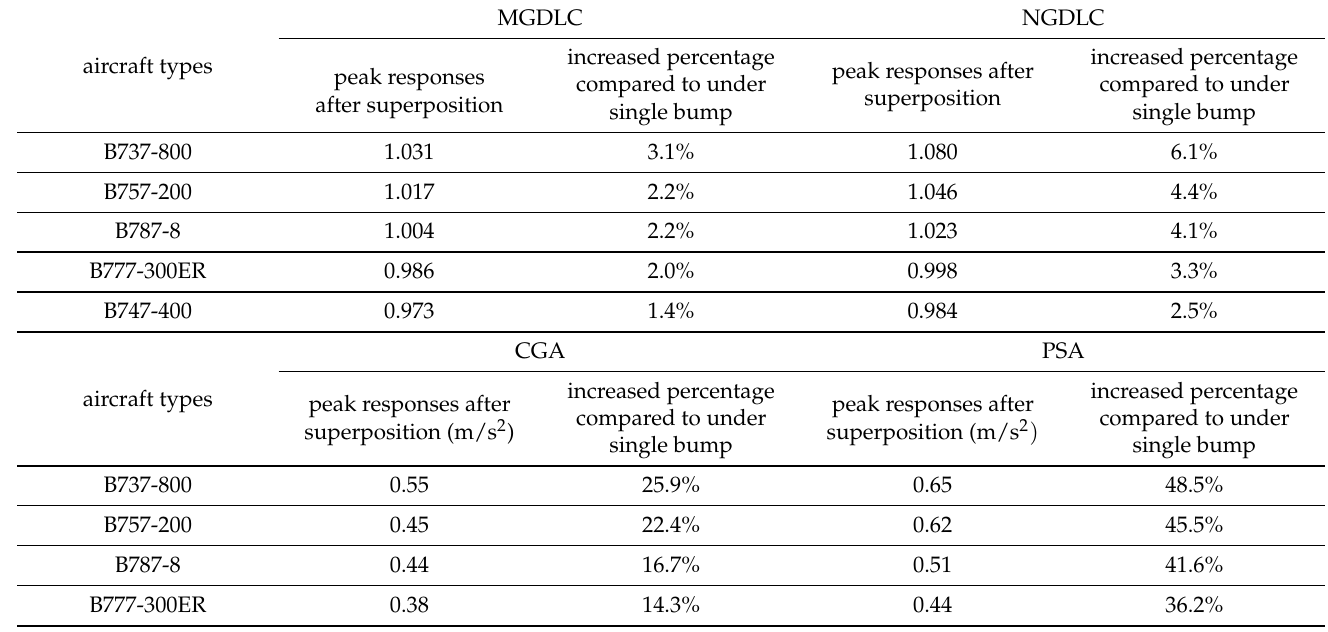
Figure 9. Maximum values of MGDLC and PSA after superposition (compared with single bump). The bump wavelength is set to the aircraft’s sensitive wavelength, which indicates that the frequency of the continuous excitation is the natural frequency of the aircraft. Table 8 shows the peak dynamic responses of the five types of aircraft under two identical successive bumps compared to their responses under a single bump. The increases in the peak dynamic responses (NGDLC and PSA) at the front of the aircraft after superposition are greater than the increases in those responses (MGDLC and CGA) at the center of the aircrafts. This trend becomes increasingly more distinct with the diminishing size of the aircraft type. Table 8. Peak responses and increases following superposition of two successive